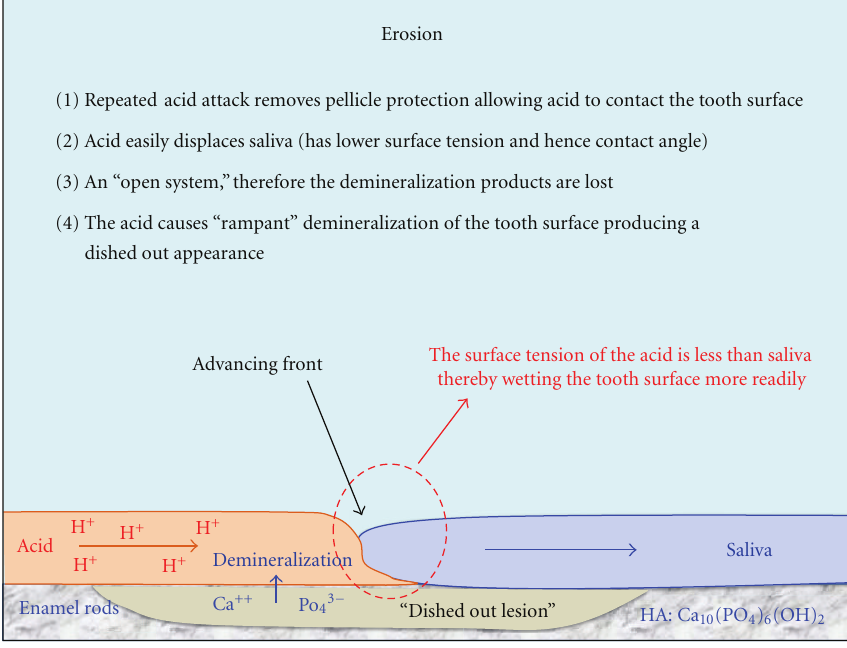
Figure 2: When dental pellicle is removed by sustained endogenous acid attacks, then demineralized tooth products are lost to the oral environment. HA: hydroxyapatite. (Amended Figure 2 . 5, page 15, from Smales et al. [67]. With copyright permission from Jaypee Medical Publishers